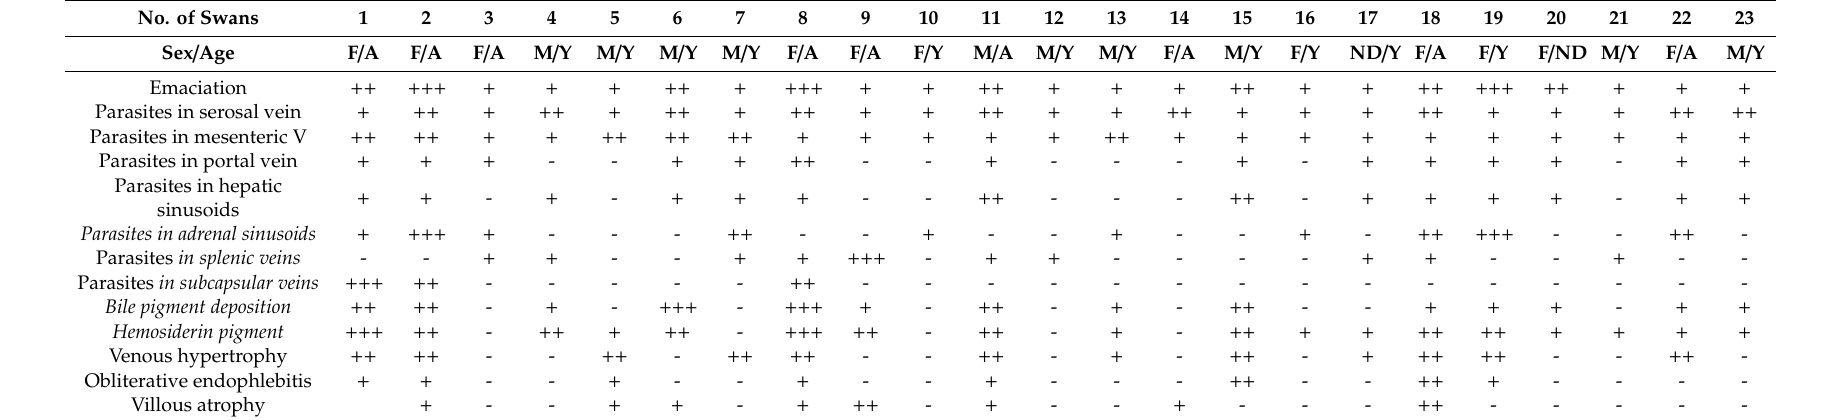
Table 1. Summary of histopathological lesions and worm findings in 23 infected whooper